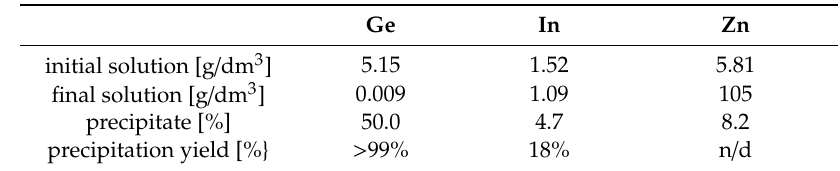
Table 3. Composition of solution and precipitate obtained after cementation (75 ◦ C, 2 h, 100 g / dm 3 Zn dust, final pH 2.0).